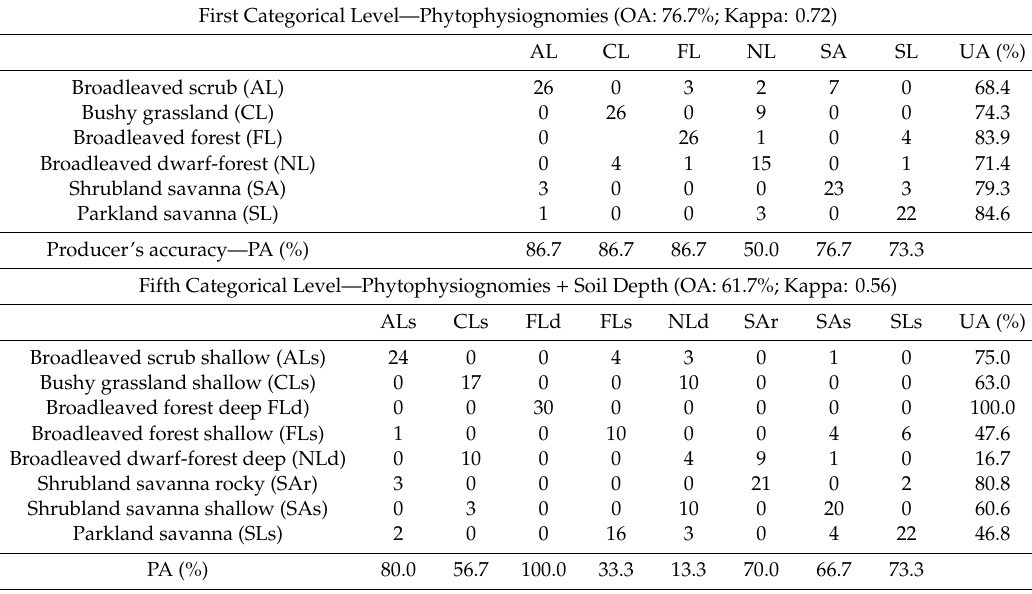
Table 4. Confusion matrix (validation dataset) of Random Forest models for both taxonomic